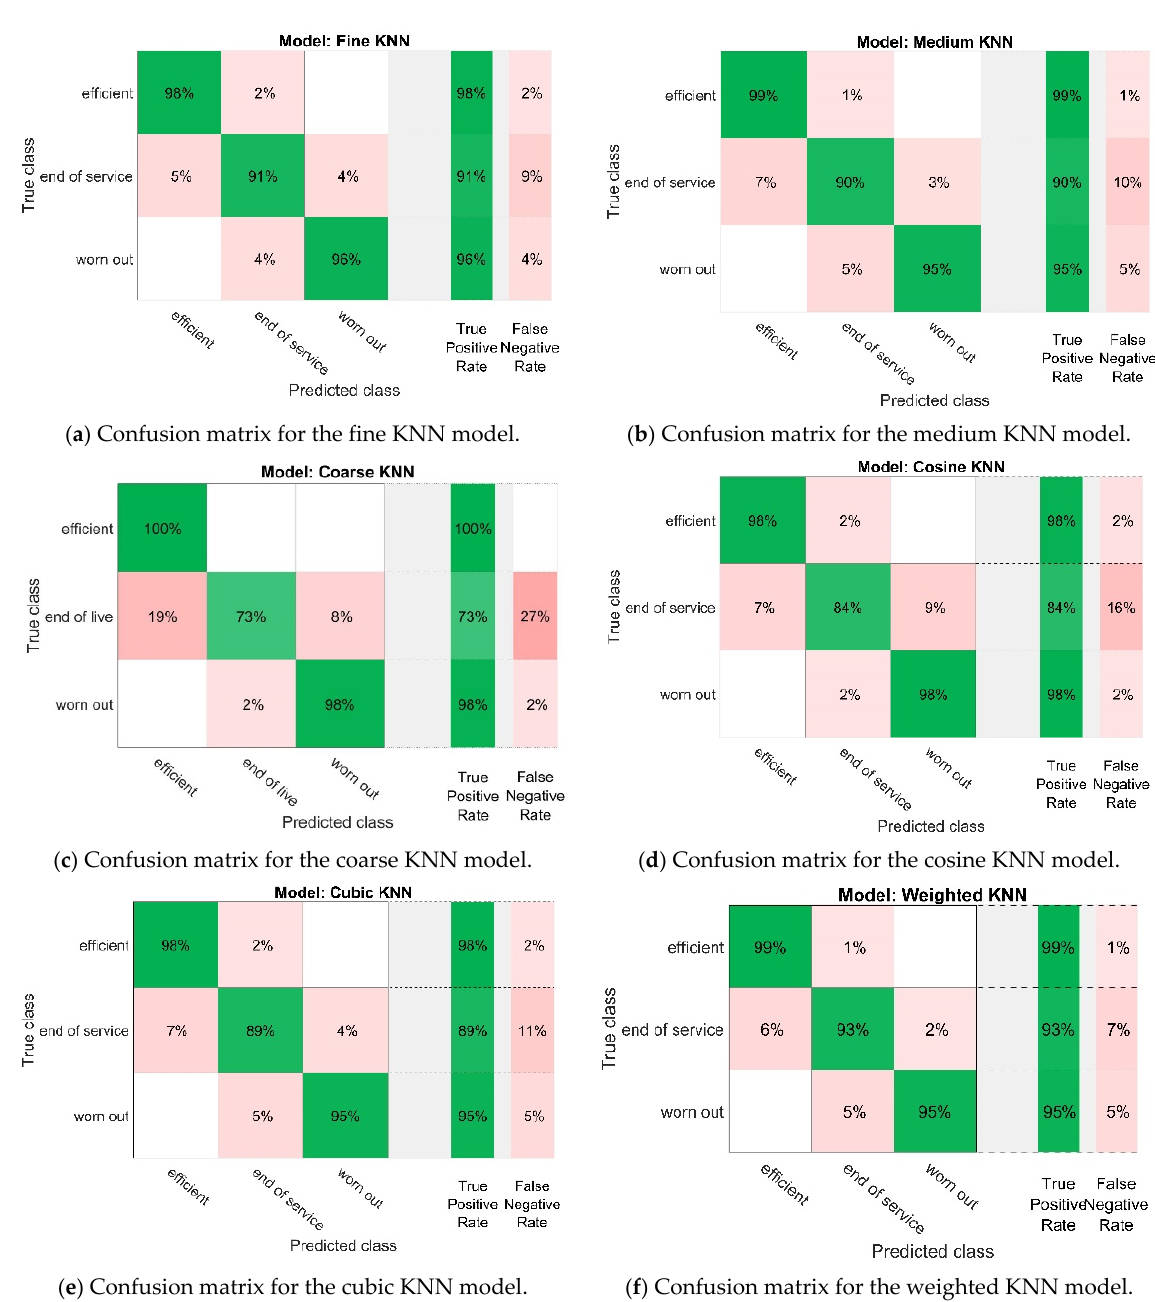
Figure 7. Confusion matrices of the wear condition classification obtained from models using the K -Nearest Neighbours classifier.